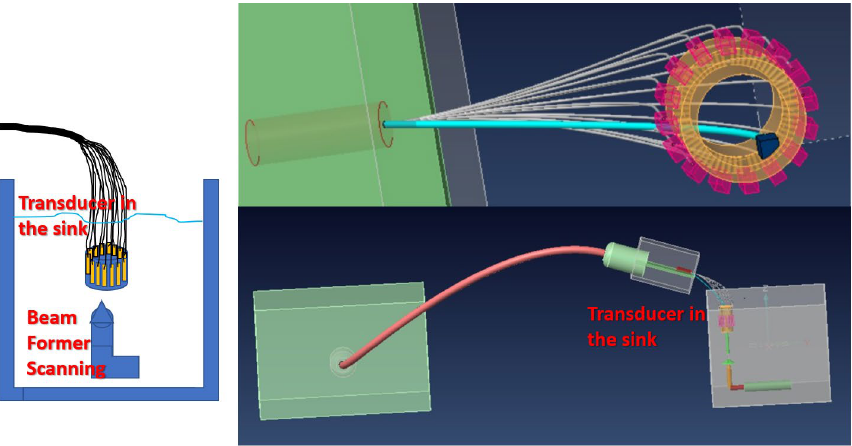
Figure 2. Specific 16-channel circular microelectromechanical systems (MEMS)-transducer array. This study chose to increase the voltage supply to Channel 5 as shown in Figure 3 (A), which generated satisfying ultrasonic energy in the first experimental stage, to drive the piezoelectric element, which had a resonance frequency and loop resistance of 2.3759 MHz and 19.729 Ω, respectively ( Figure 3).